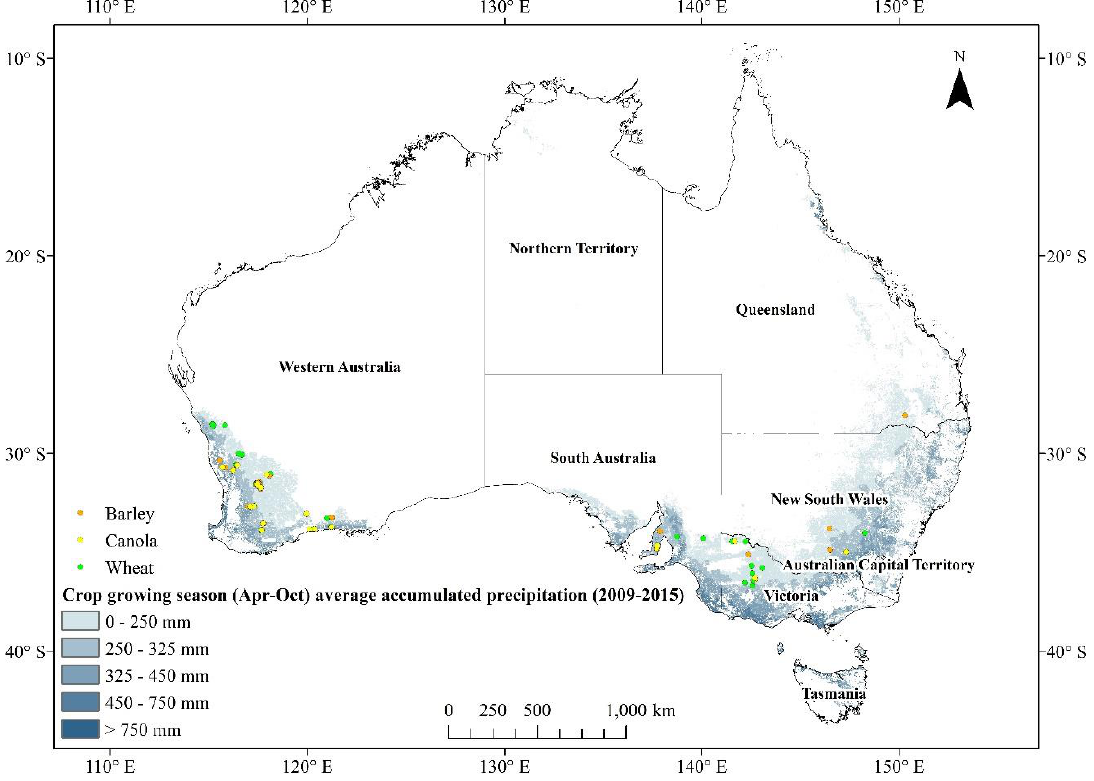
Figure 1. Study sites and the crop growing season (April–October) average accumulated precipitation (mm for the years 2009–2015) across the Australian wheatbelt (~53 million ha) [13]. The precipitation data are sourced from Jeffrey et al. [37] .